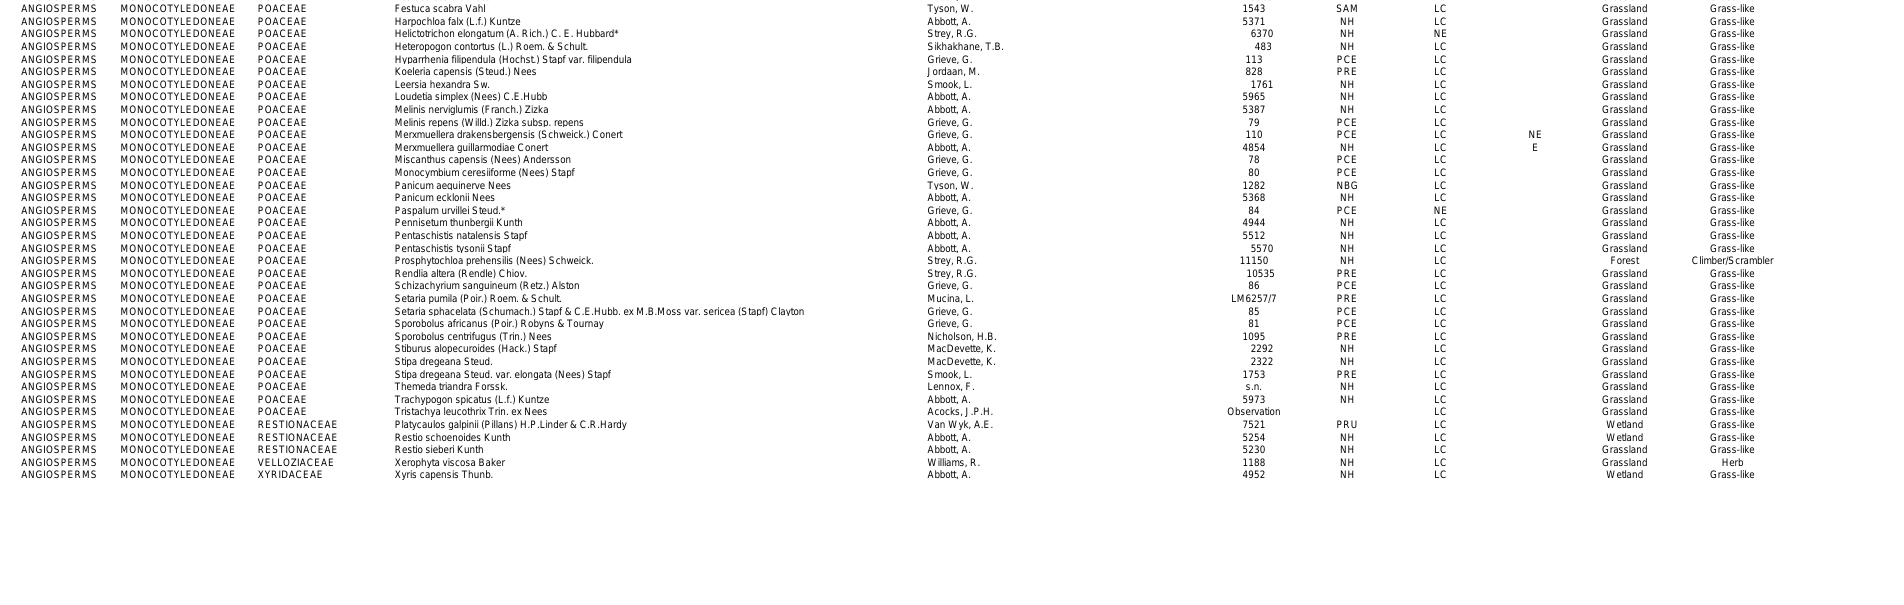
Hyparrhenia filipendula (Hochst.) Stapf var.